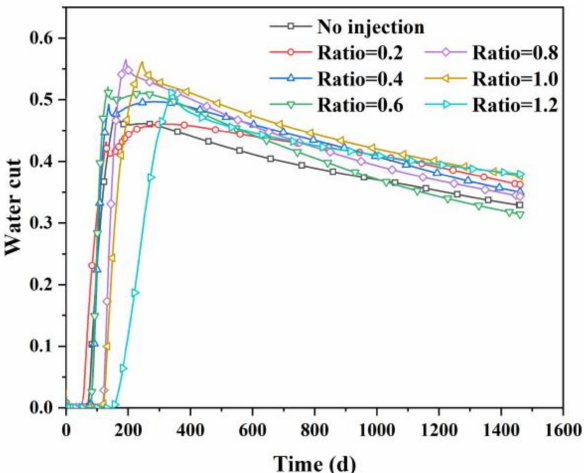
Figure 18. Water cut of infill well.